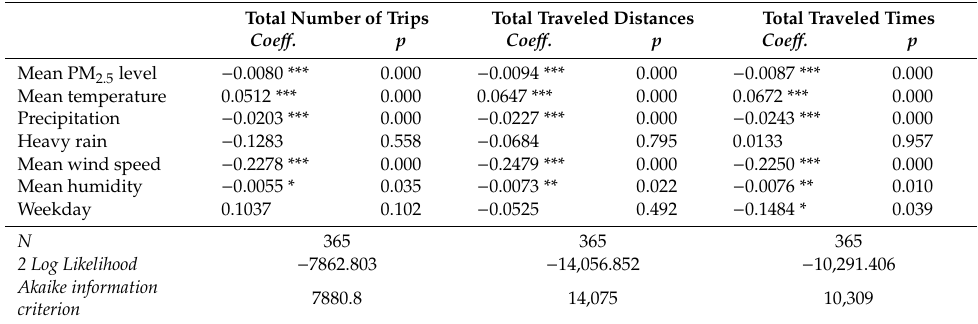
Table 4. Estimation results for bike sharing use using PM 2.5 level data in all seasons.